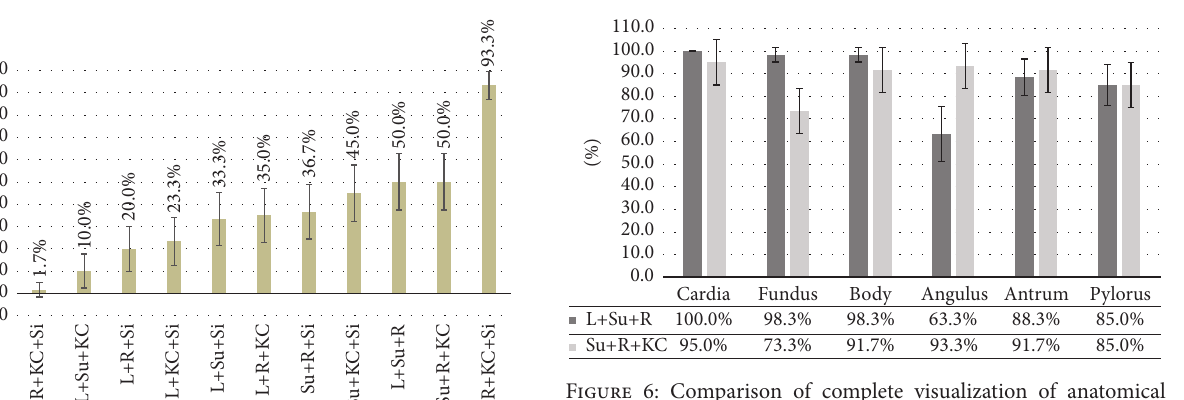
Figure 6: Comparison of complete visualization of anatomical landmarksfromSu+R+KCandL+Su+Rcombinations.L:leftlateral; Su: supine; R: right lateral; KC: knee-chest; Si: sitting. (98% versus 85.9%). Compared with the results of Rey et